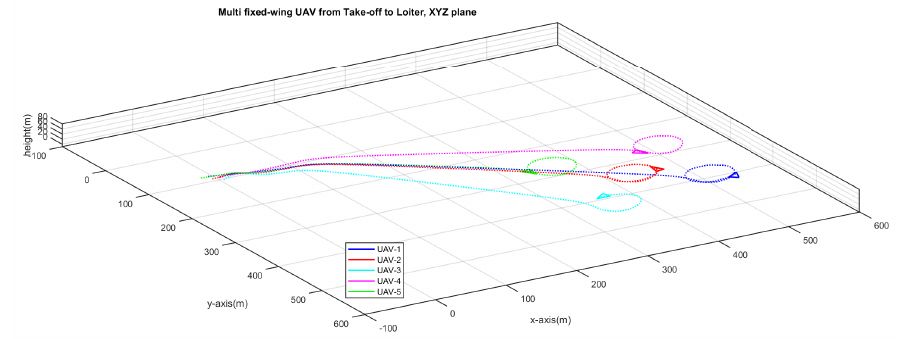
Figure 16. After take-off, the UAVs reach different loitering points.